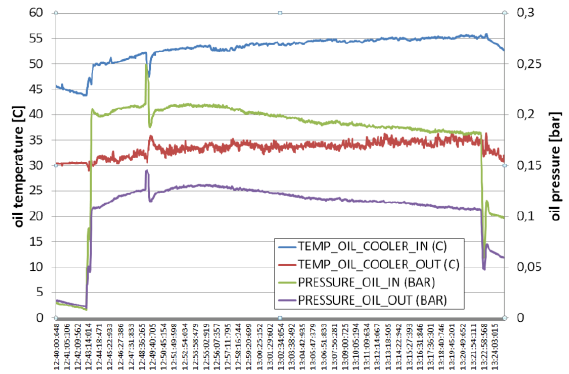
Fig. 6. Temperature and pressure of hydraulic oil measured before and after the oil cooler